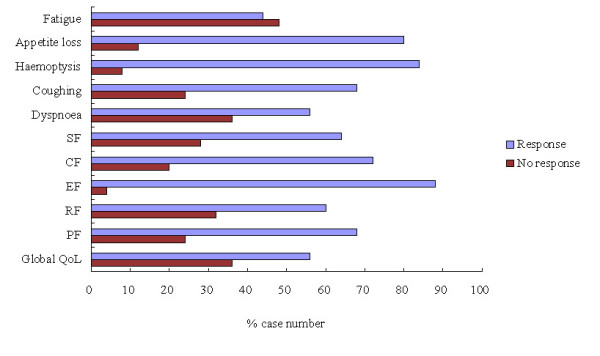
Patient response for QoL and main symptoms QoL, quality of life; PF, physical functioning; RF, role functioning; EF, emotional functioning; CF, cognitive functioning; SF, social functioning